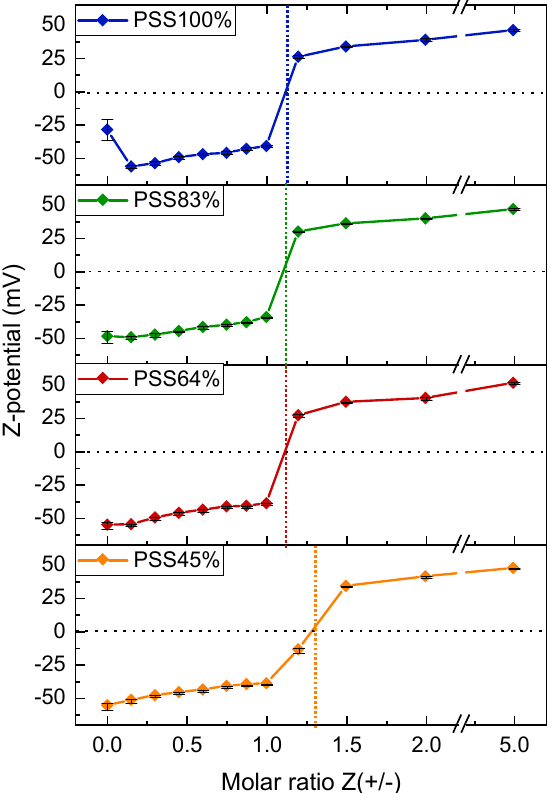
Figure 8. Zeta potential measurements of PDADMAC/P(St-co-SSNa) complexes in solution as function of the molar charge ratio Z(+/ − ) for the four P(St-co-SSNa) compositions. Zetametry was performed on same samples as those used in Figure 7. The total PE concentration was 1.5 mM in charged units. The point of zero charge is indicated by the dotted lines Solid lines are only to guide eyes.